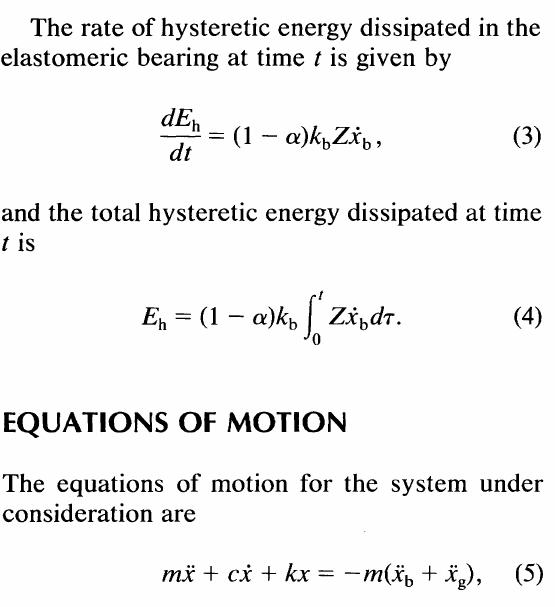
FIGURE 2 Force-deformation behavior of the iso